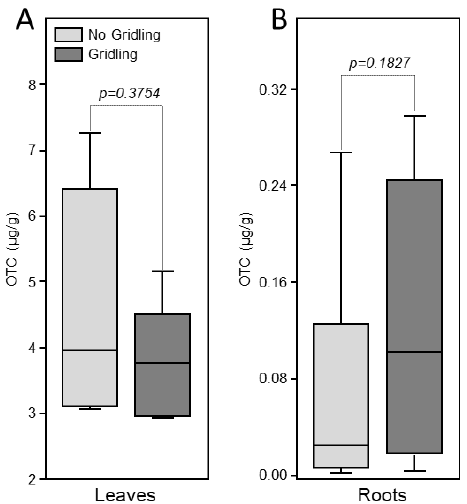
Figure 3. Box-plot of the levels of oxytetracycline in leaves ( A ) and roots ( B ) of citrus trees 72 h after trunk injection of 20 mL of Fireline solution (equivalent to 255 mg oxytetracycline). Data are the means ± SD of five biological replicates (field trees). Means with p -value > 0.05 are not significantly different using the t -test.